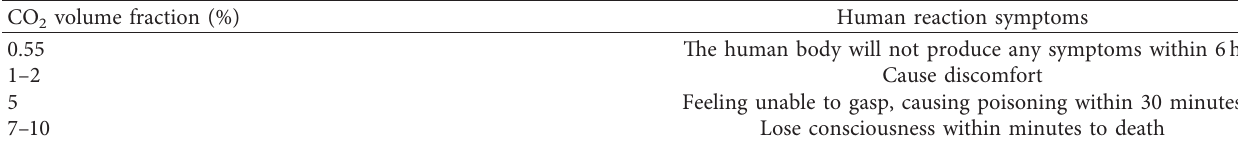
2 on the human body.